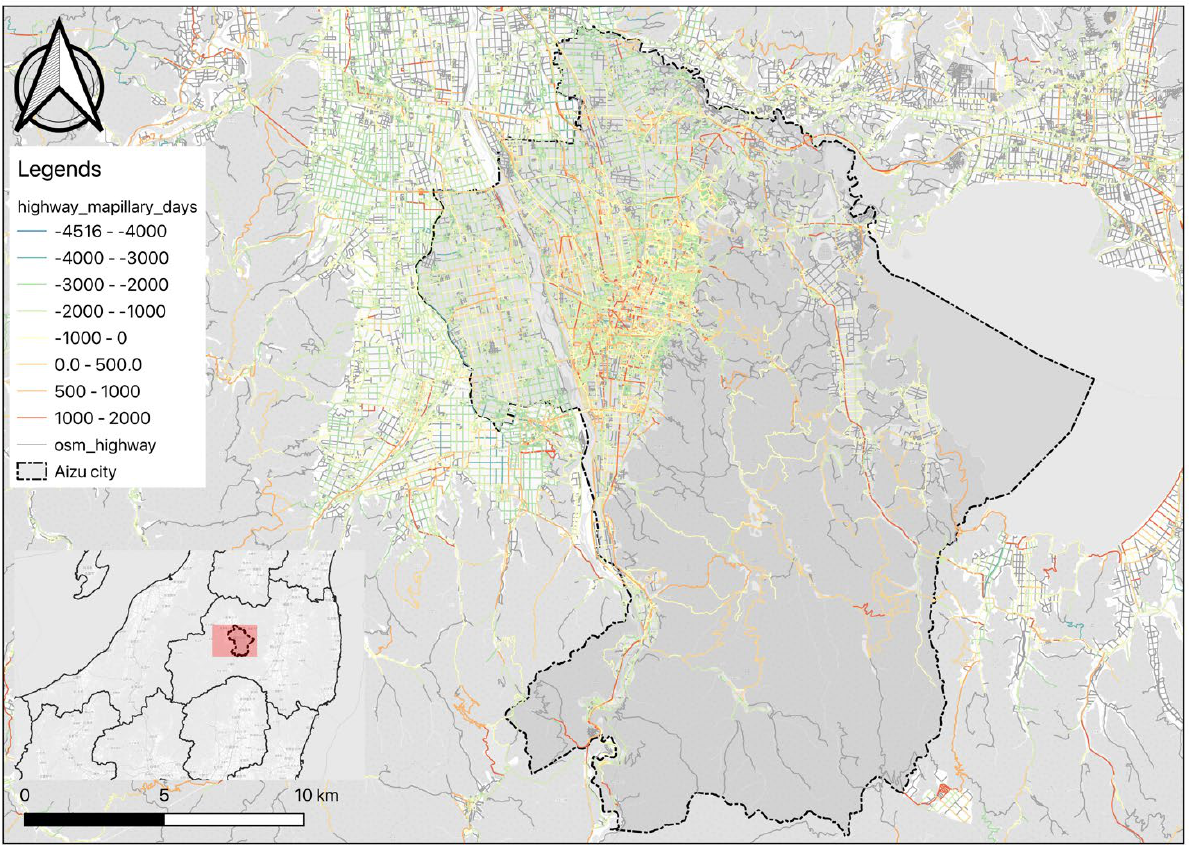
Figure 10. Distribution of Mapillary-OpenStreetMap roads in Aizu